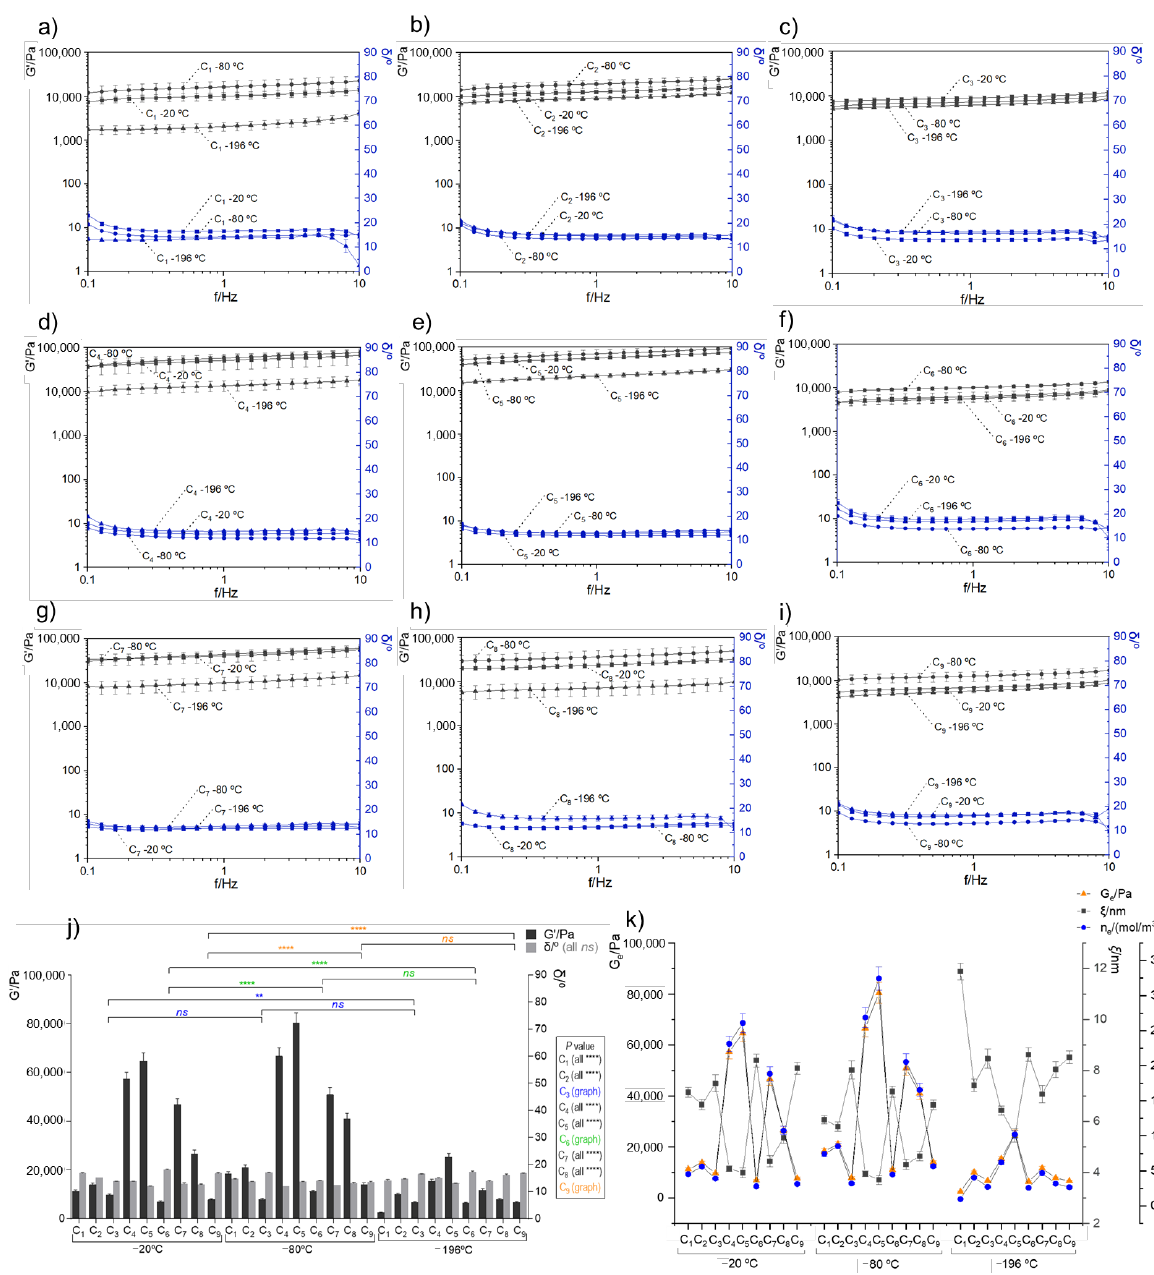
Figure 3. Oscillatory rheological behavior of different marine origin cryogels ( a – i ) corresponded to the developed cryogels C 1 to C 9 , respectively, produced at − 20, − 80, and − 196 °C. Data show the mean of three values from independent experiments and the standard error for G ′ /Pa (black lines) and the phase angle δ/ ° (blue lines). ( j ) Comparison of each marine cryogel as a function of G ′ /Pa and the δ/ °, with the average stable zone between 0.5 to 5 Hz. All differences between samples were statistically significant **** p < 0.0001 except those represented with the symbols of ** ( p < 0.01) and ns (not significant). ( k ) Comparative analysis of the storage modulus at the plateau (G e /Pa), mesh size ( ξ /nm), and the crosslinking density (n e /mol·m 3 ) of the developed marine cryogels.